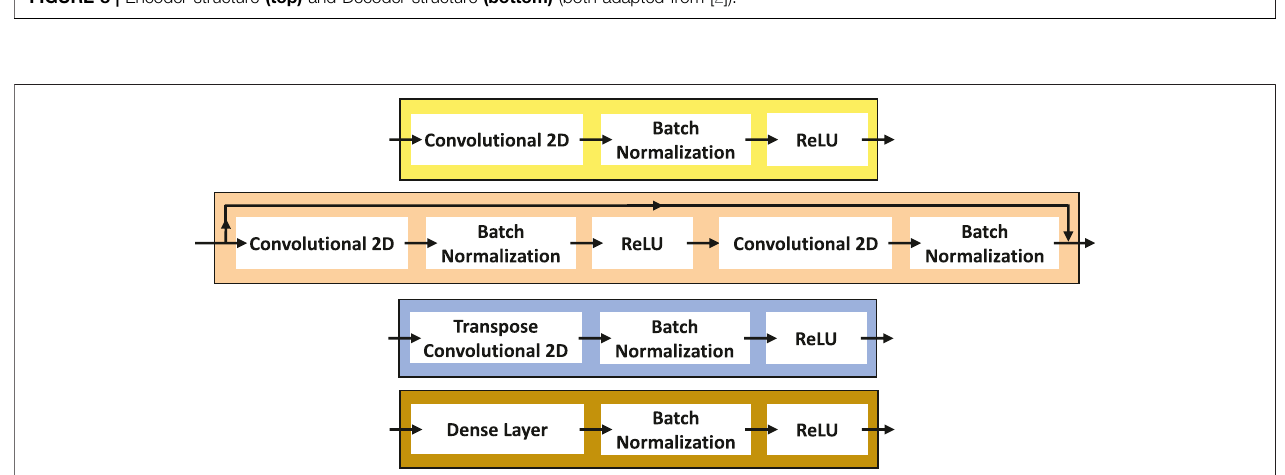
FIGURE 8 | Encoder structure (top) and Decoder structure (bottom) (both adapted from